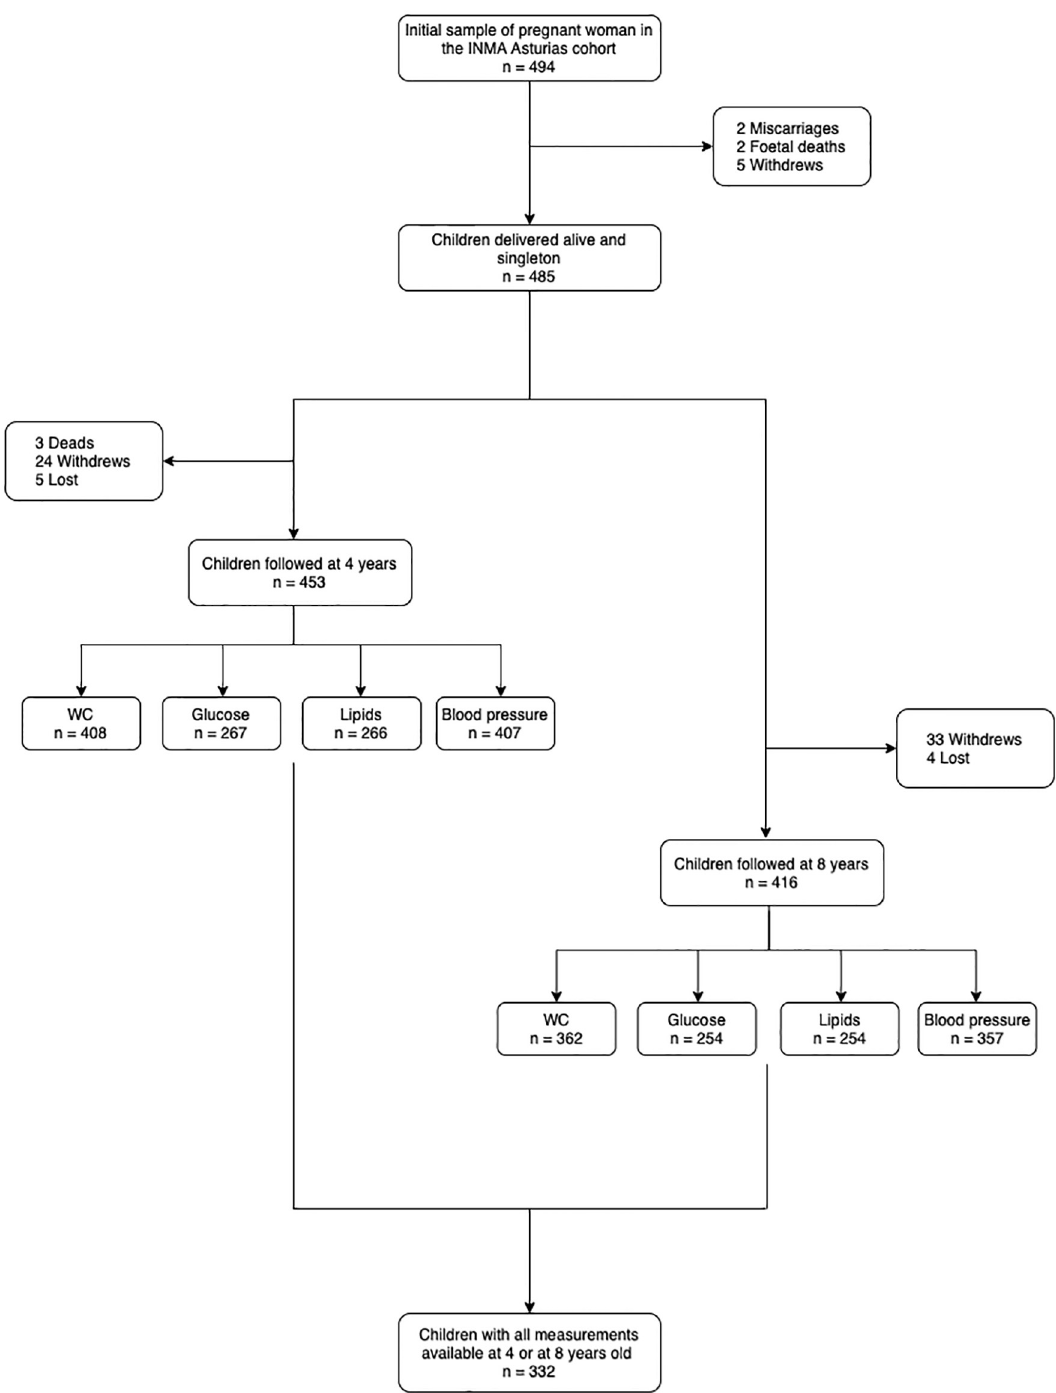
Fig 1. Flowchart of the study population. WC, waist circumference.